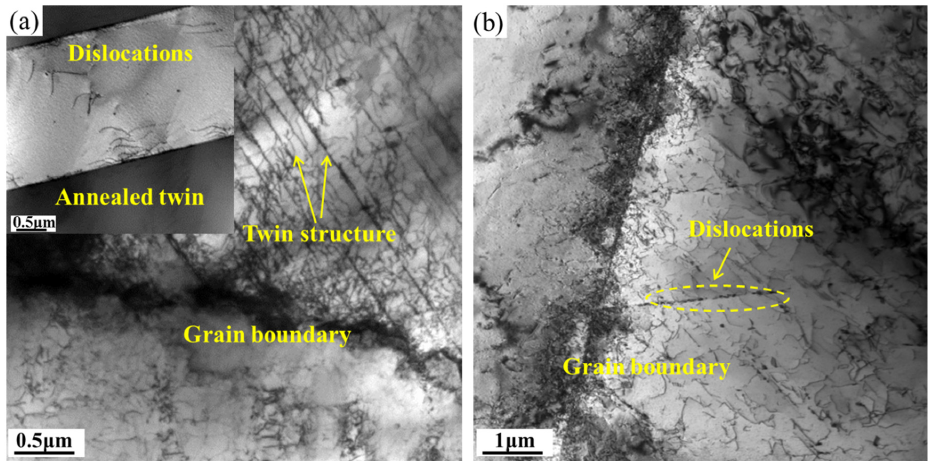
Figure 12. Atomic probe maps and concentration profile of the sample subjected to HAZ.